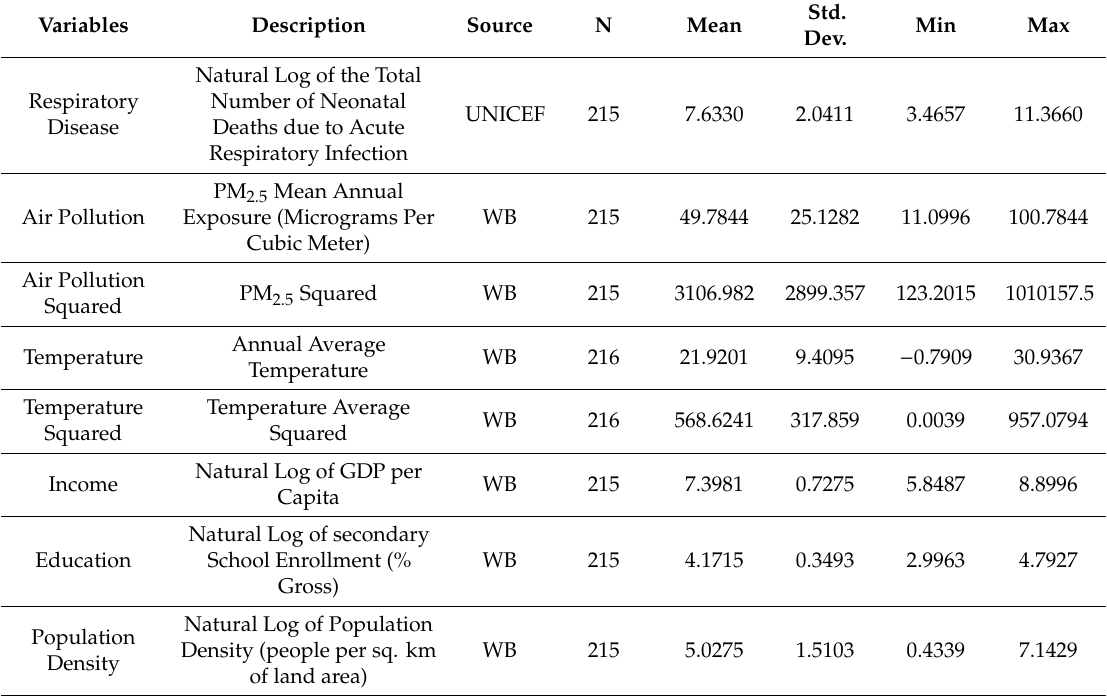
Table 3. Variable description and descriptive statistics.